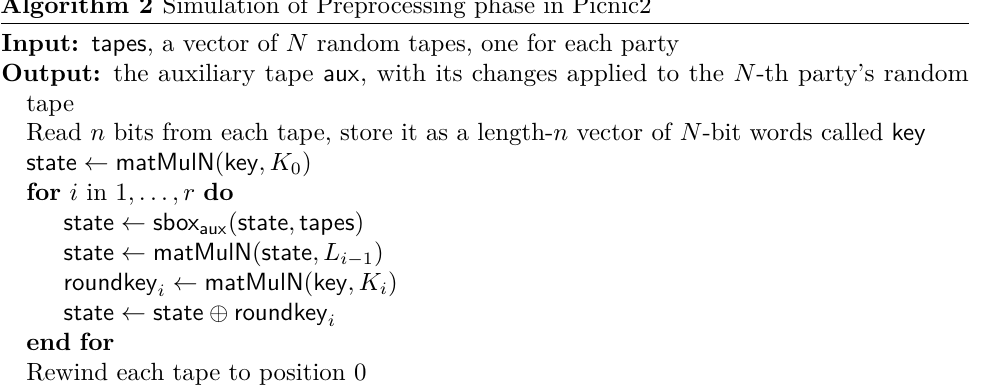
Algorithm 2 Simulation of Preprocessing phase in